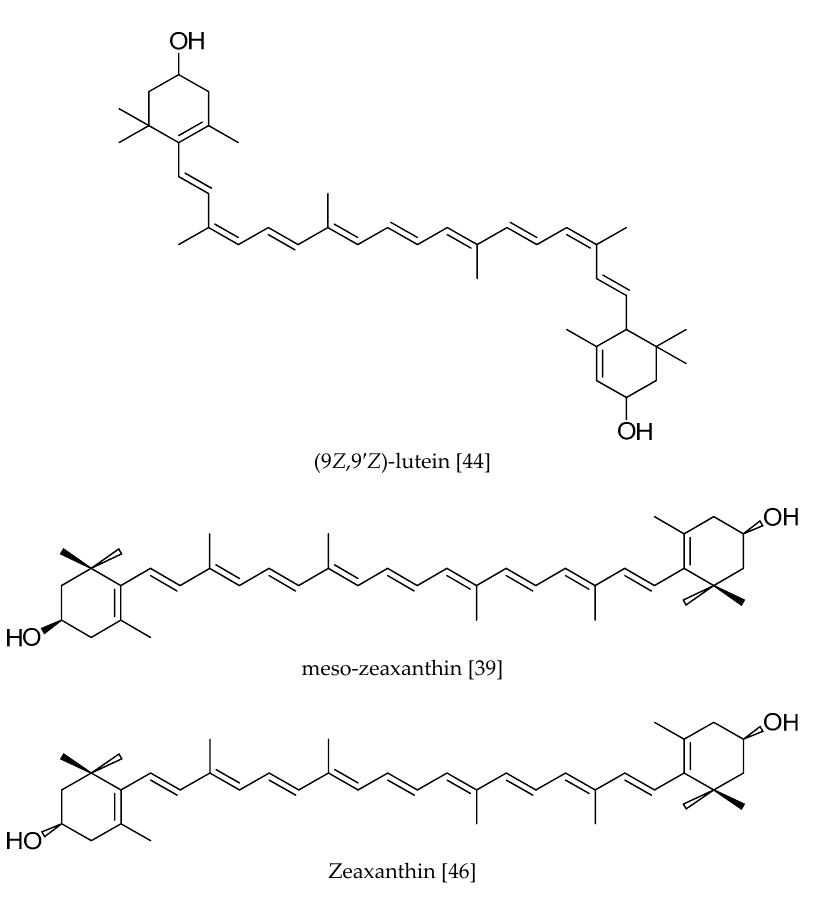
Figure 1. The structures of L, Z and their stereoisomers.